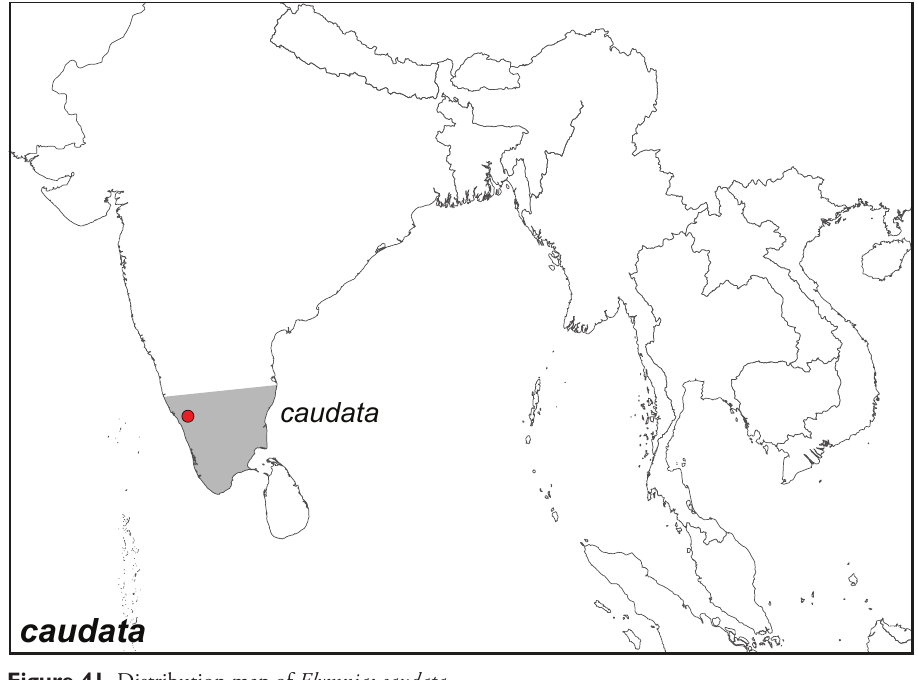
Figure 41. Distribution map of Elymnias caudata .